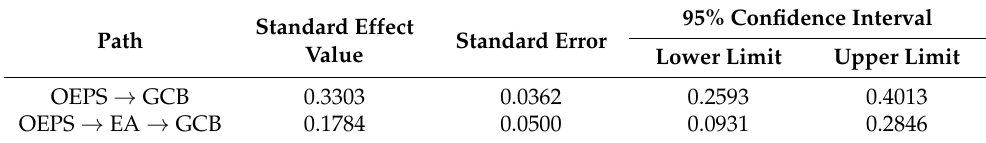
Table 7. The results of the direct effect and the mediating effect using the bootstrap method.